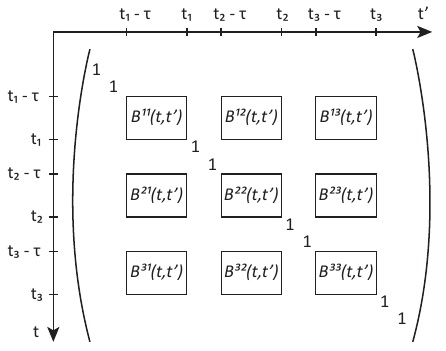
Figure 2: The matrix structure of B ( t , t (cid:48) ) as defined in Eq. (7). Here, B ( t , t (cid:48) ) is shown for a scattering phase containing 3 window